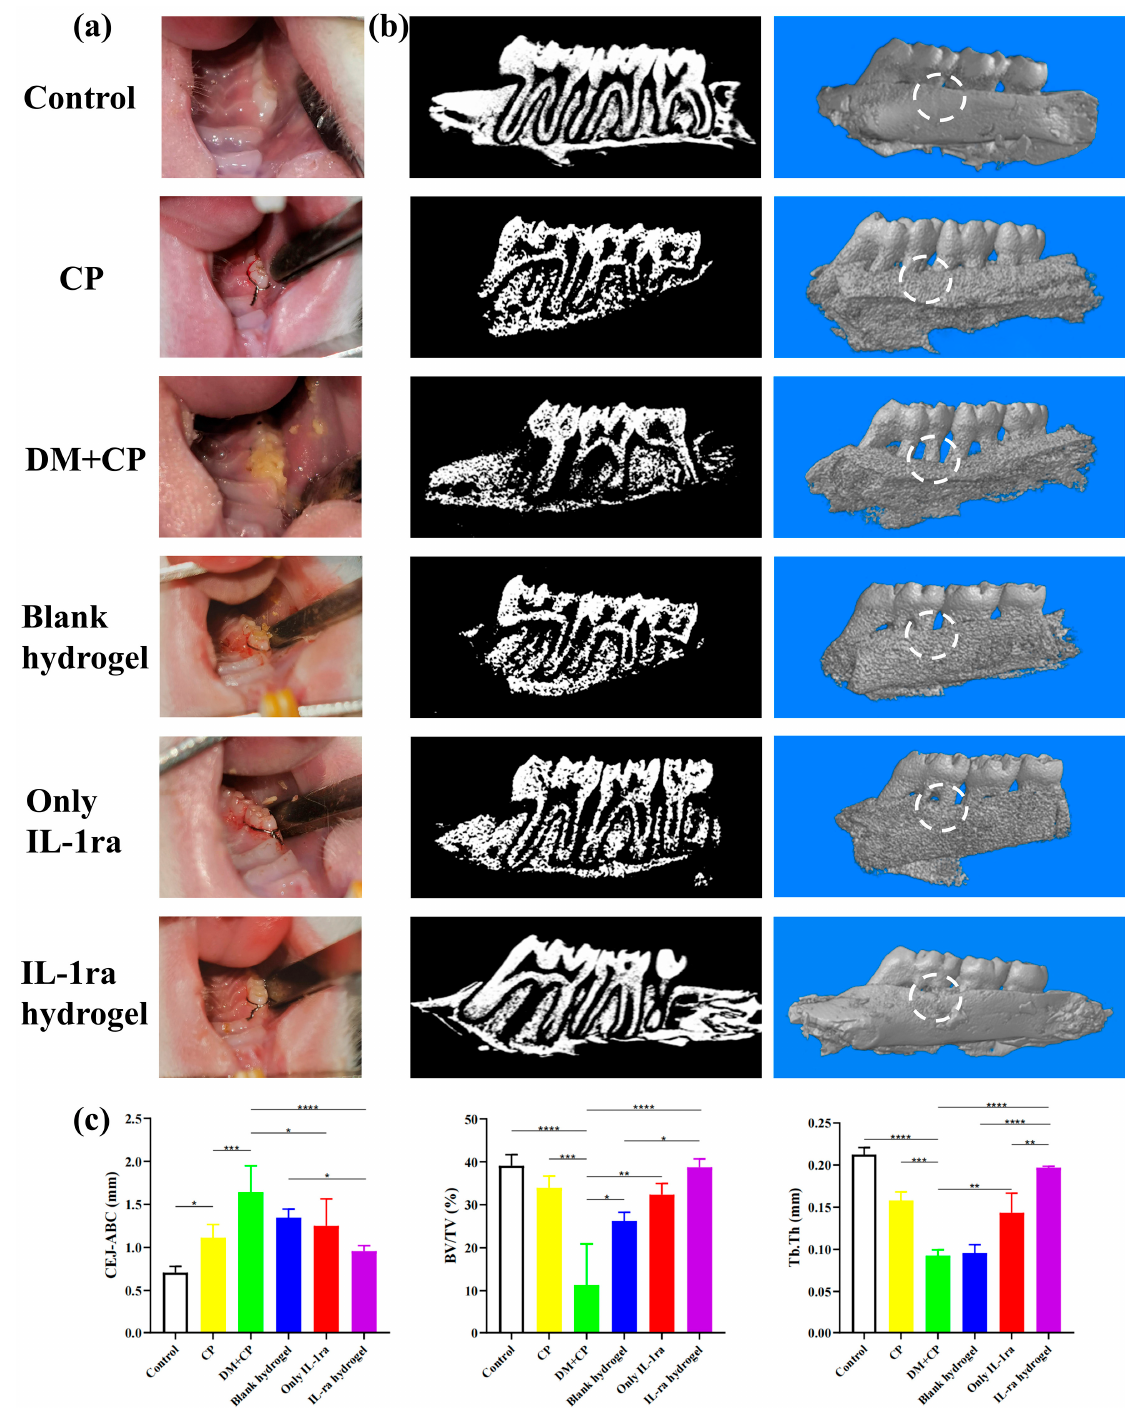
Figure 4. Effect of IL-1ra-loaded CS/ β -GP/gelatin thermosensitive hydrogel on alveolar bone in rats. ( a ) Photos of periodontitis models induced by ligature around maxillary first molars of rats in groups I, II, III, IV, V, and VI. ( b ) Micro-CT images of maxillary alveolar bone surrounding the maxillary first molars and maxillary second molars four weeks after the treatment: the images with black background are representative sagittal Micro-CT slices; the images with blue background are three-dimensional Micro-CT reconstruction images. The circled area is the subsequent analysis area of alveolar bone parameters. ( c ) Quantitative analysis of ABL, BV/TV, and Tb. Th determined by Micro-CT images. *: p < 0.05, **: p < 0.01, ***: p < 0.001, ****: p < 0.0001.